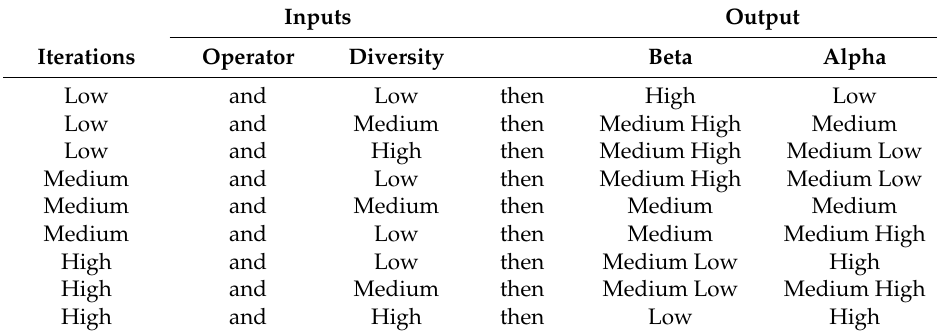
Figure 8. Fuzzy bee colony algorithm. Table 1. Fuzzy rules for the FBCO. Table 1. Fuzzy rules for the FBCO.